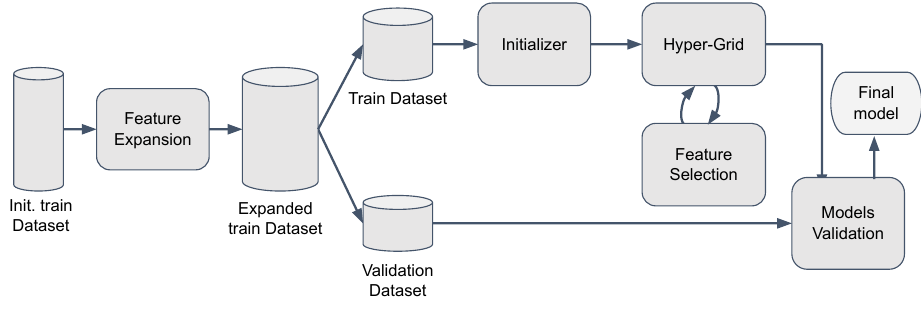
Figure 2. MAMOTH Pipeline